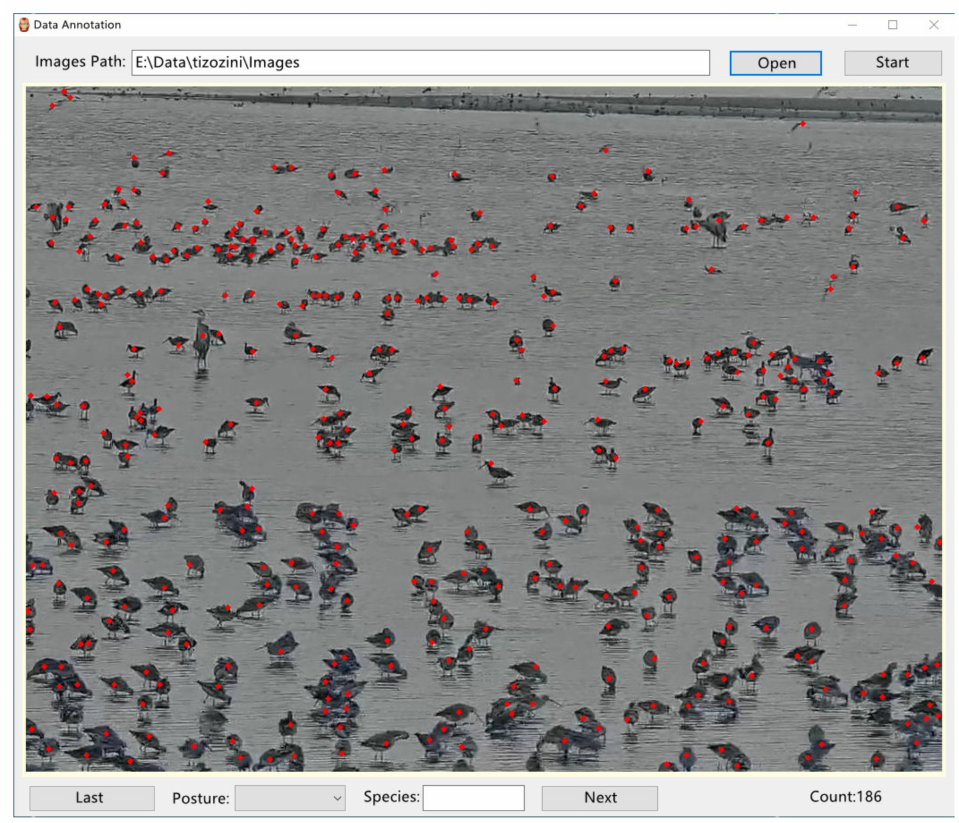
Figure 3. The interface of the annotation tool. Every bird in an image is marked as a red dot, and the coordinated points are saved for further